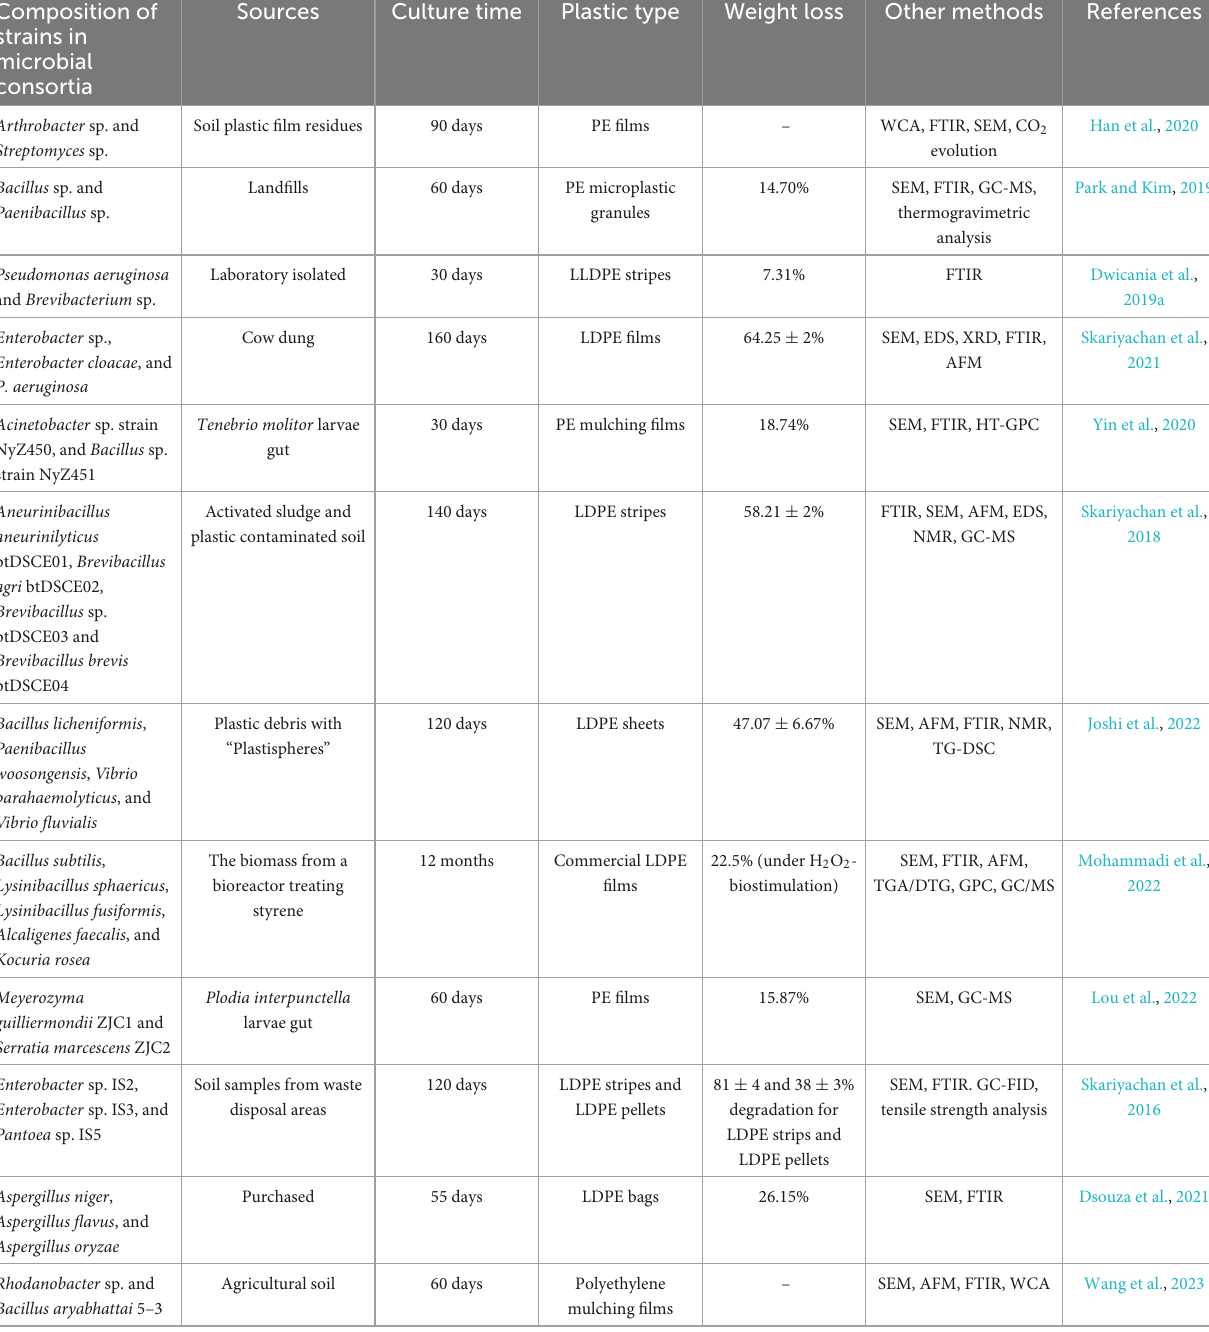
TABLE 3 Microbial consortia/co-cultures constructed with capacity for polyethylene